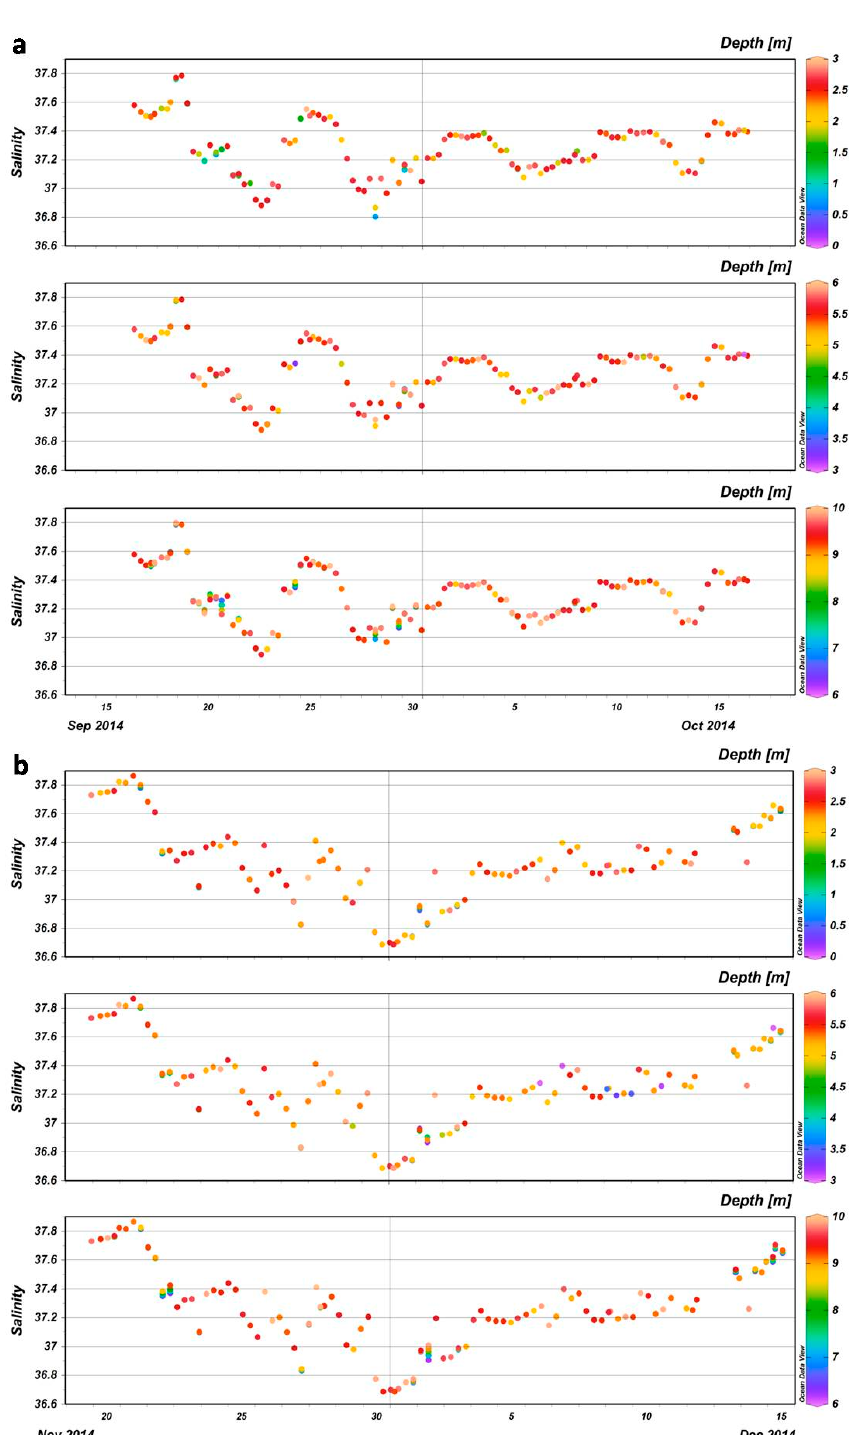
Figure 2. Glider sea surface salinity (SSS) collected in the first 10 m depth during the ABACUS missions 1.1 ( a ) and 1.2 ( b ). For each survey, observations are split into three bands, i.e., 0–3 m, 3–6 m, and 6–10 m depth.